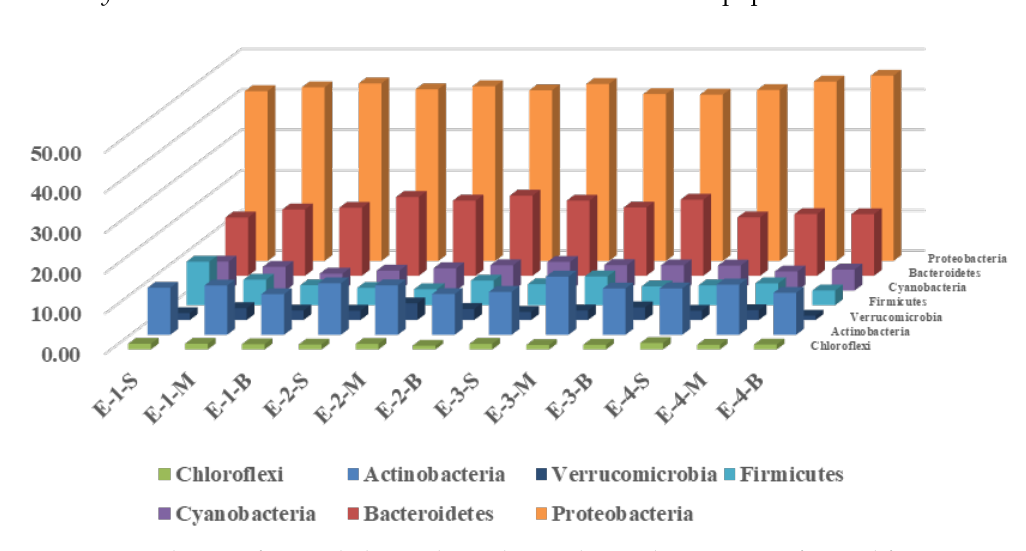
Figure 4. Distribution of main phyla in enhanced areas during the operation of water lifting aerators (The vertical axis represents the percentage of di ff erent bacteria; X-Y-Z, area-period-location; X = C and E are control and enhanced areas; Y = 1, 2, 3, 4 refer to 2018-09-28, 2018-10-15, 2018-10-29, 2018-11-28; Z = S, M, B, are surface, medium, and bottom water layer).